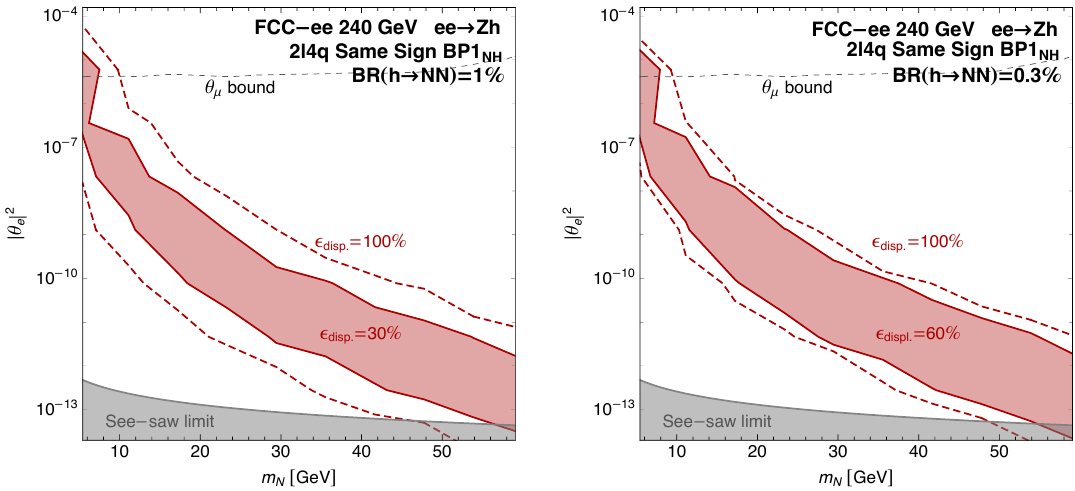
Figure 7 . 95% CL exclusion for BP1 NH in the m N − | θ e | 2 plane from displaced decay searches in the Higgs-strahlung channel assuming BR( h → NN ) = 1% (left) and 0.3% (right) for the case of FCC-ee. The shaded red area and the dashed red lines represent the sensitivities for different assumptions on the efficiencies for reconstructing the displaced vertices (cid:15) disp . . The gray dashed line represents the limit on the mixing angle arising from existing experimental searches. In the gray shaded region the lightness of the neutrino masses cannot be explained by the see-saw